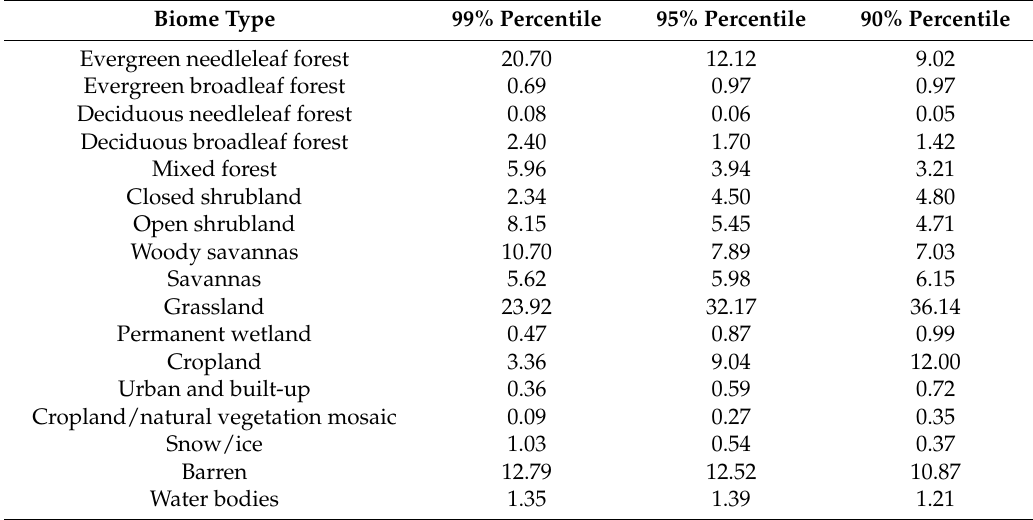
Table 8. Pixel proportion of different biome types at three relative standard deviation percentile levels.